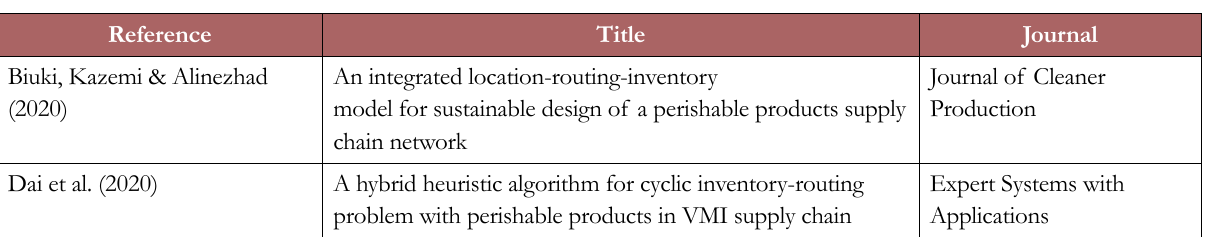
Table 4. Selected papers